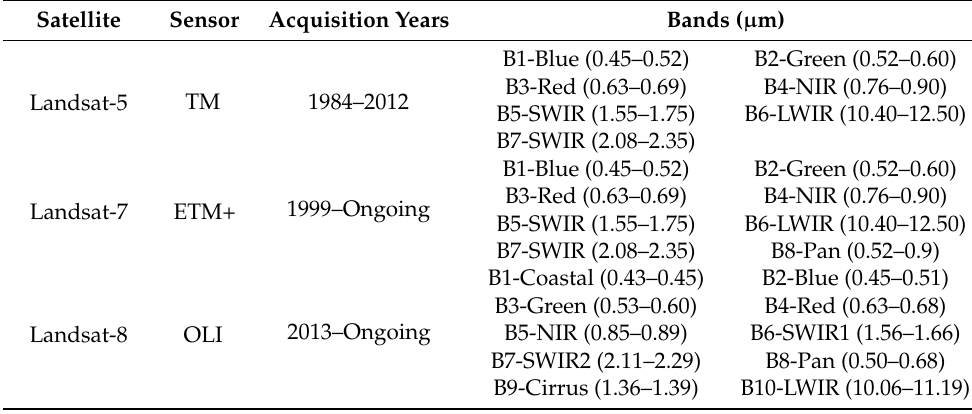
Table 1. Used Landsat satellite parameters.